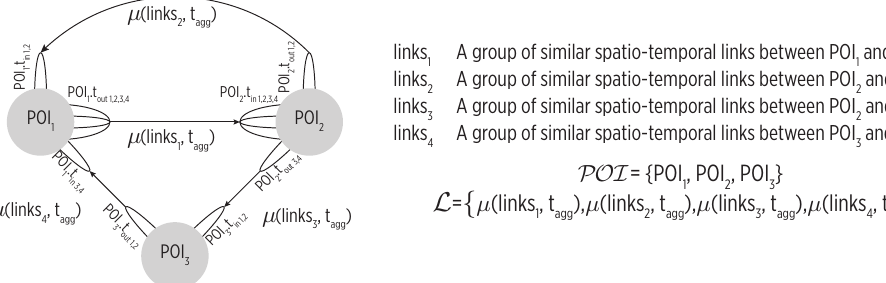
Figure 4. The cognitive map as a multigraph, where nodes represent the POIs and edges the time-annotated trajectories (links) followed by the user when moving between